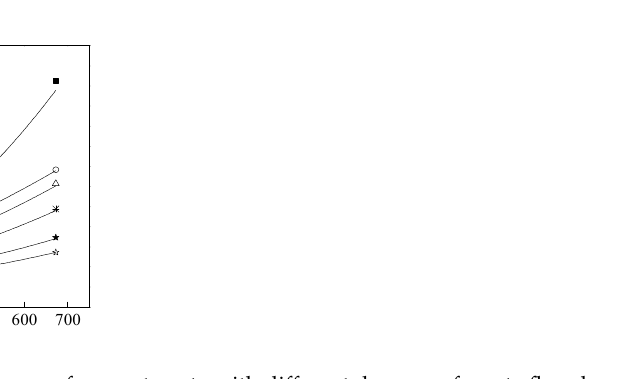
Figure 5. The AC electrical resistance of cement paste with different dosages of waste fly ash. Table 3. Mixing mass proportion of cement paste.